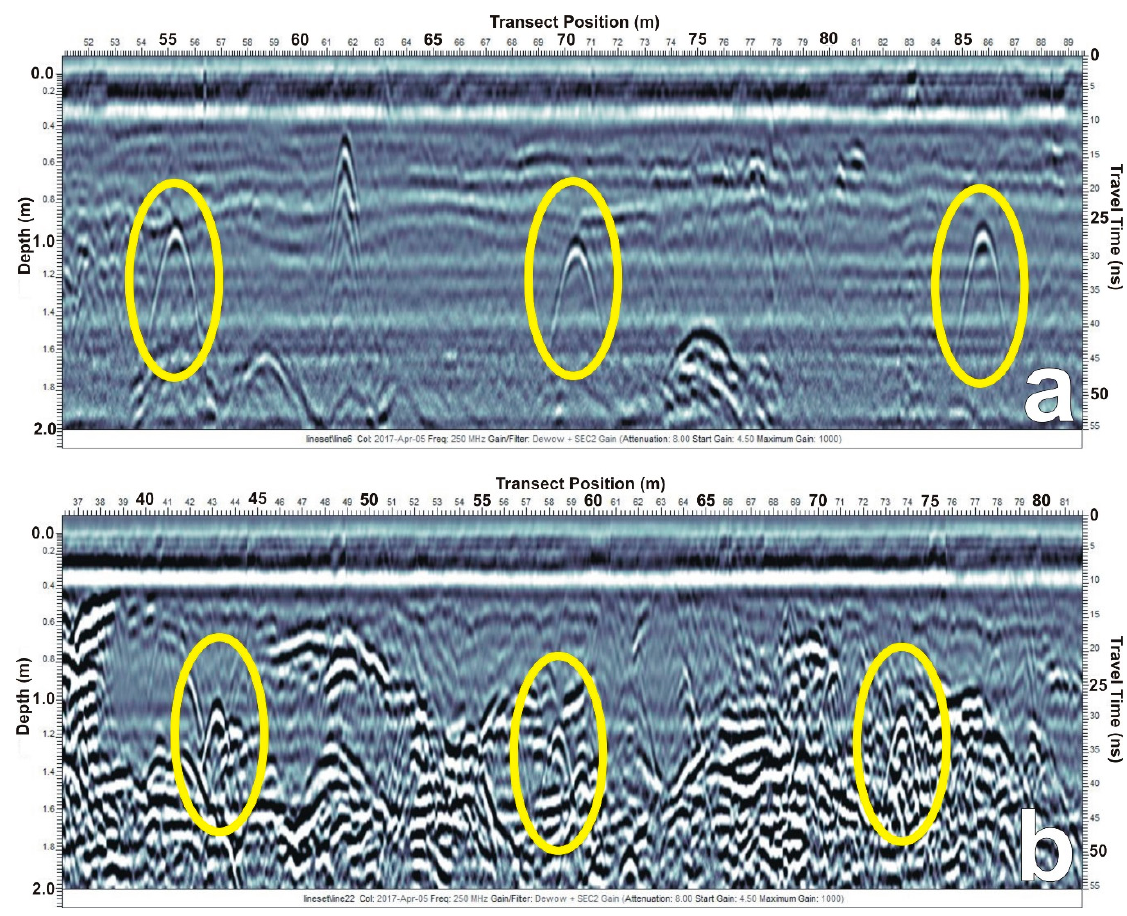
Figure 8. GPR profiles showing reflection hyperbola potential drainage pipe responses highlighted by yellow line ovals; ( a ) homogeneous soils on west side of Site 1; ( b ) heterogeneous soils on east side of Site 1. The reflection hyperbola potential drainage pipe responses are far easier to discern in the homogeneous soils as opposed to the heterogeneous soils.